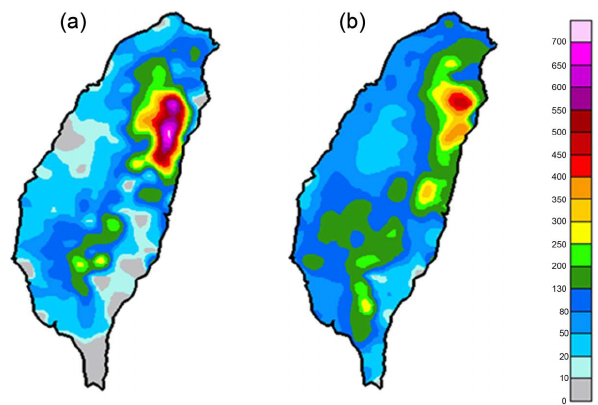
Fig. 3. The accumulated rainfall for Typhoon Longwang: (a) ob- Fig 3. The accumulated rainfall for Typhoon Longwang: (a) observed (0530 LST 1 2 served (05:30 LST, 1 October–08:30 LST, 3 October); and (b) the Oct – 0830 LST 3 Oct); and (b) the rainfall distribution estimated using TRCM06. 3 rainfall distribution estimated using